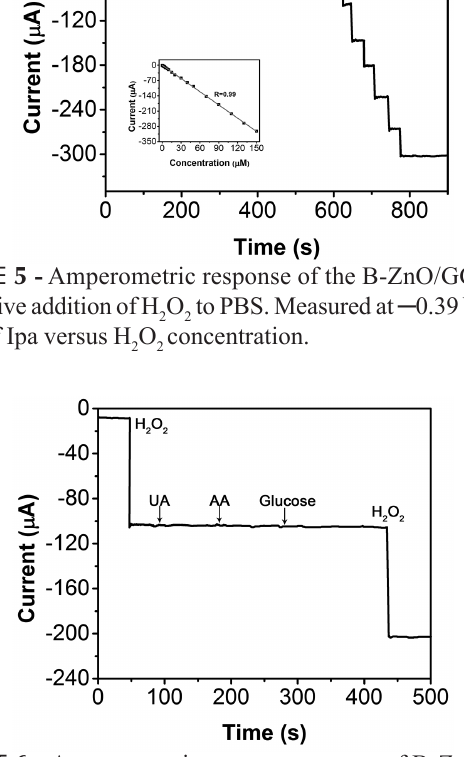
FIGURE 6 - Amperometric current response of B-ZnO/GCE to the addition of 0.05 mM H ascorbic acid (AA), 1 mM glucose and 0.05 mM H operating potential of - 0.39 V.